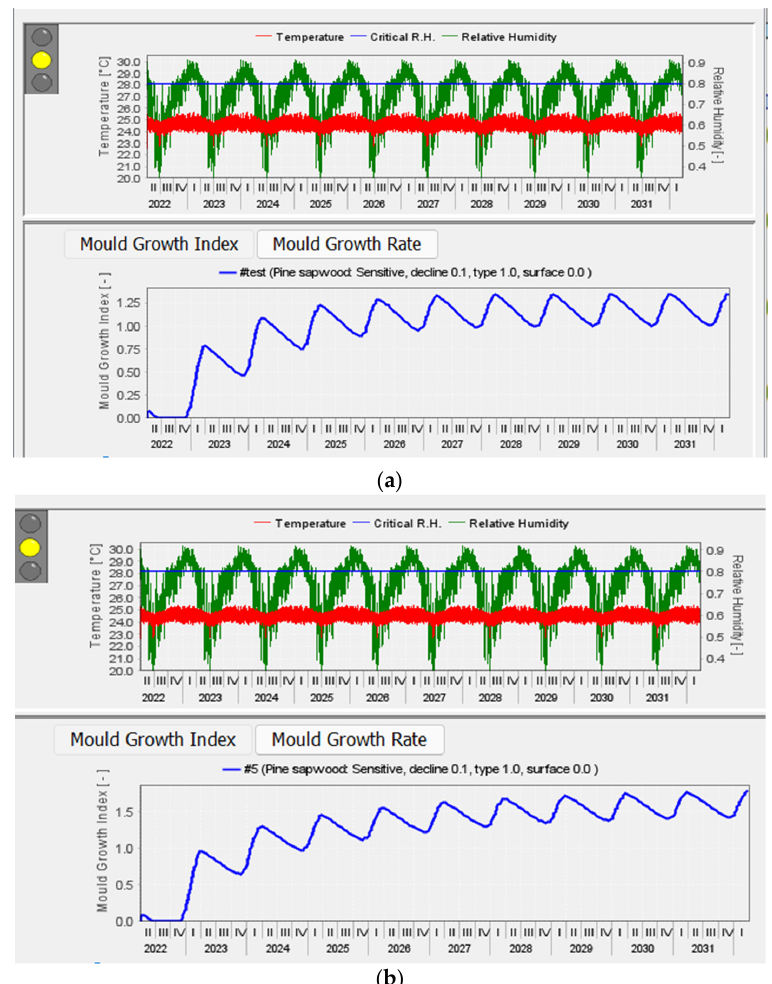
Figure 19. ( a ): Mould Growth Index graph for the wall assembly with single point resistivity value of membrane A in west orientation of Australian hot and humid climate; ( b ): Mould Growth Index graph for the wall assembly with multipoint resistivity value of membrane A in west orientation of Australian hot and humid climate.